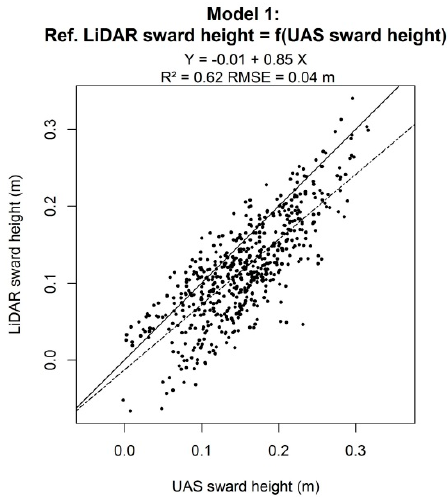
Figure 3. The linear regression (Model 1) between the reference sward height data (LiDAR) and UAS sward height data had good agreement between the two methods. The dashed line represents the fitted model and the solid line represents the 1:1 line (i.e., x = y).